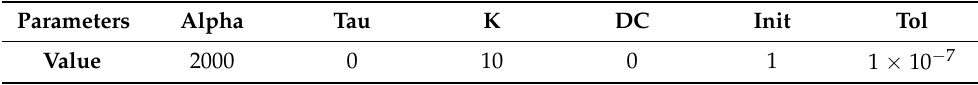
Table 2. Statistical parameters of groundwater level and climate data at three sites.